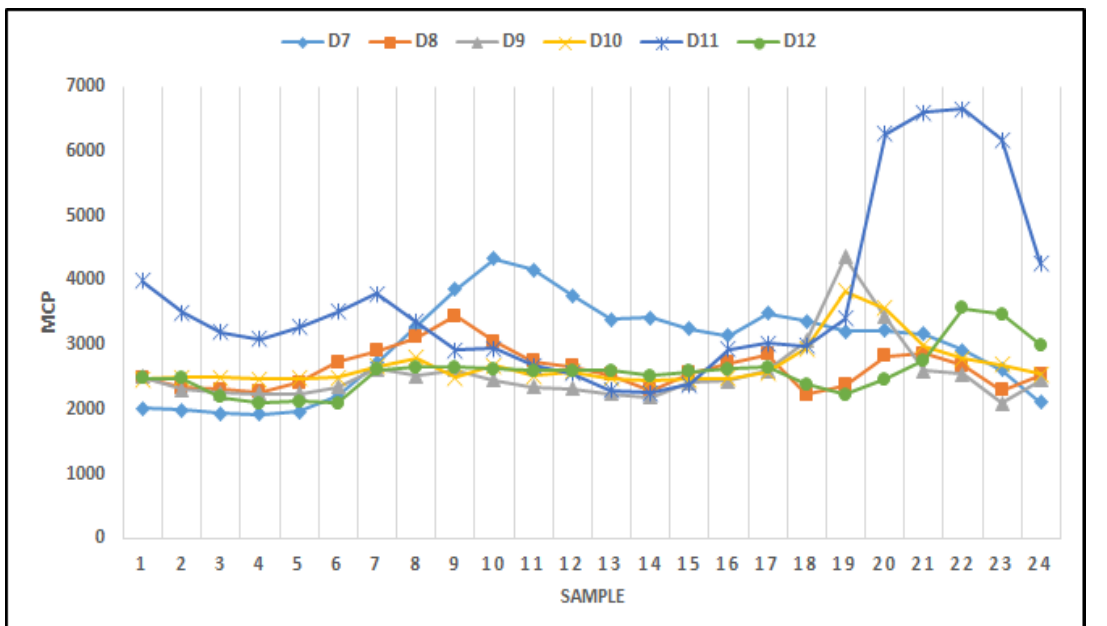
Figure 2. Data samples for evaluation of the performance of proposed cubic grey model (Case-2).